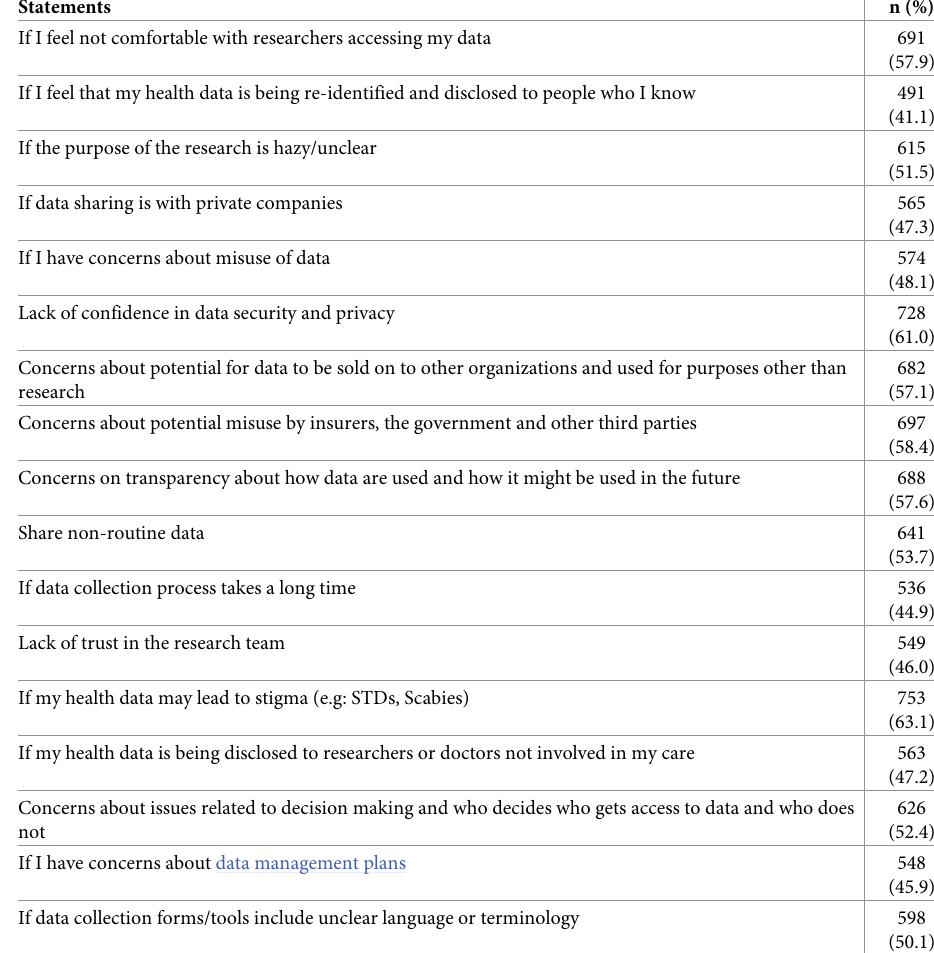
Table 3. Public perceptions towards medical data sharing barriers (n =